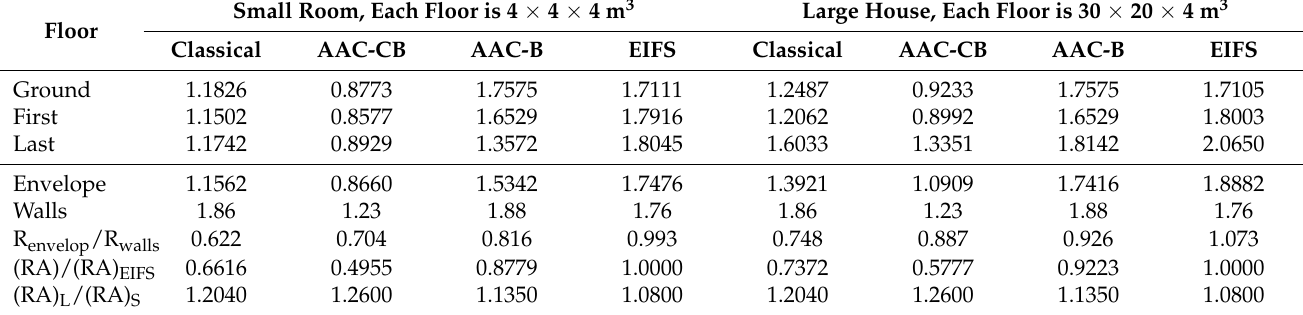
Table 7. Resistance per unit area (m 2 K/W) of the small and large buildings for various floors and the building envelope.